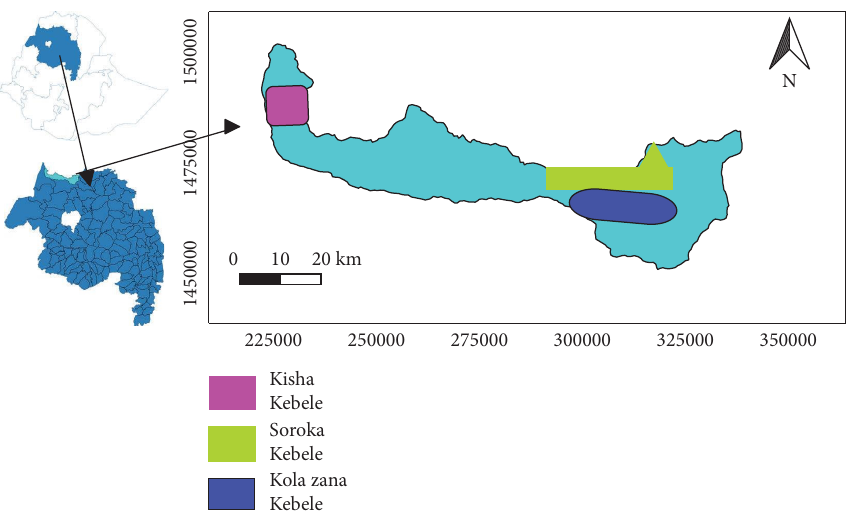
Figure 1: Map of Ethiopia, Amhara region, and Tsegede district depicting the studied sesame production